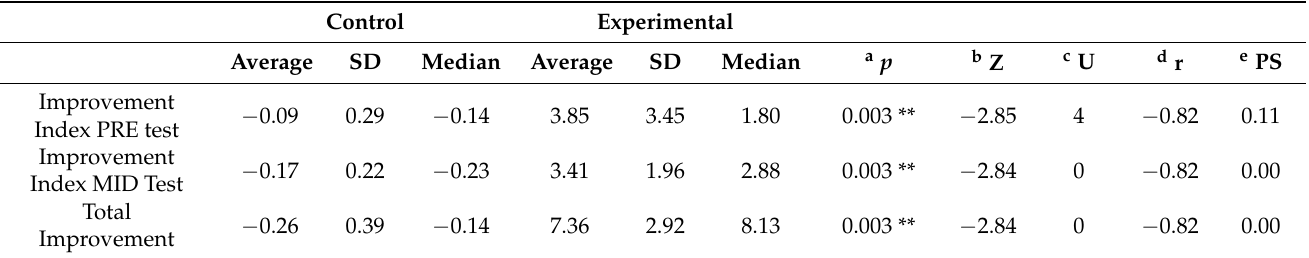
Table 3. Distribution of the improvement index of the three according to the group. Effect size and